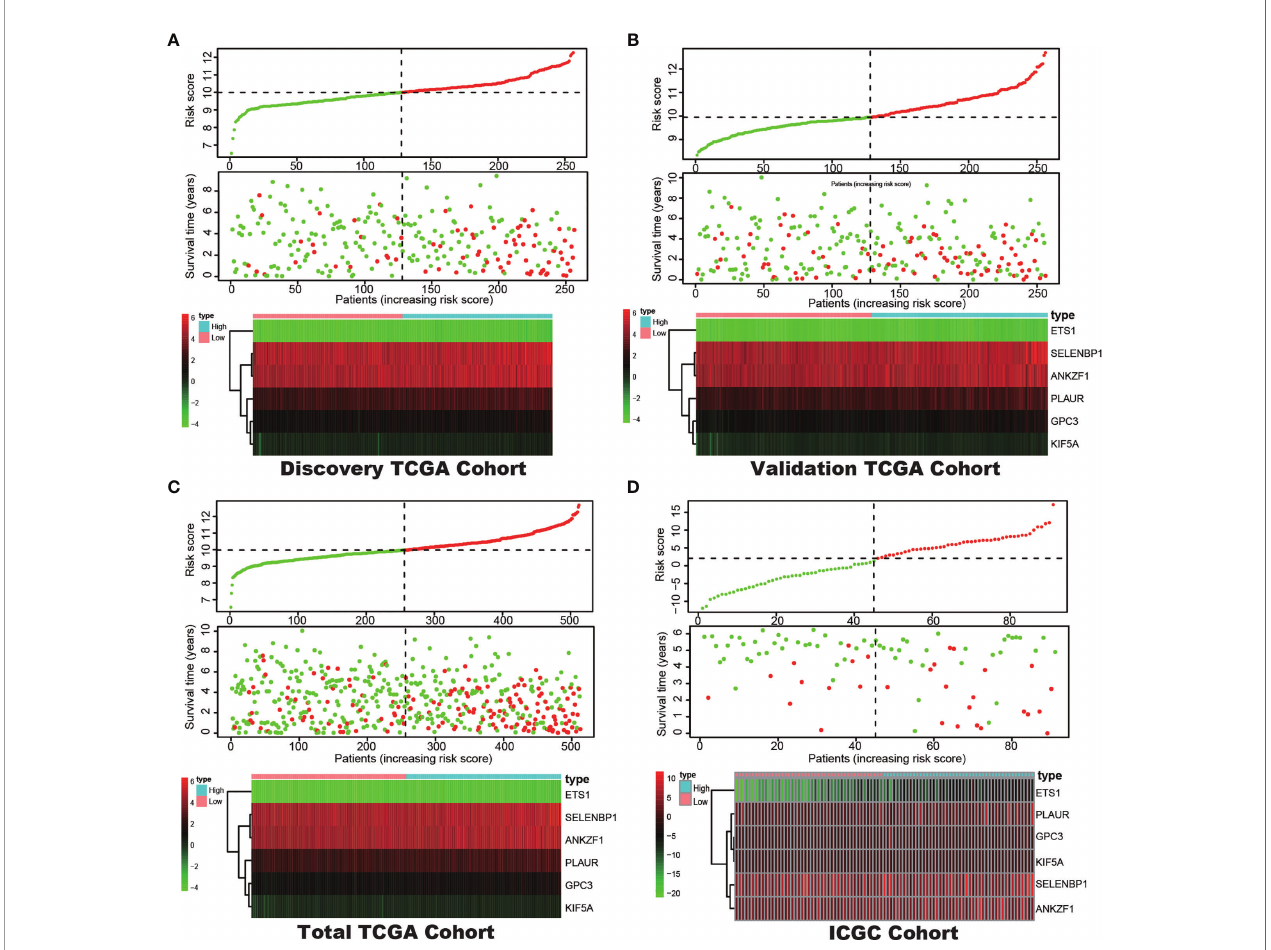
FIGURE 2 | Correlation between the prognostic model and the overall survival (OS) of patients in the Discovery TCGA Cohort (A) , the Validation TCGA Cohort (B) , the Total TCGA Cohort (C) and the ICGC Cohort (D) . The distribution of riskscore (upper), survival time (middle) and hypoxia genes expression levels (below). Patients were classi fi ed into low-risk and high-risk groups by using the median score as a cut-off value. The red dots and lines represent the patients in high-risk groups. The green dots and lines represent the patients in low-risk